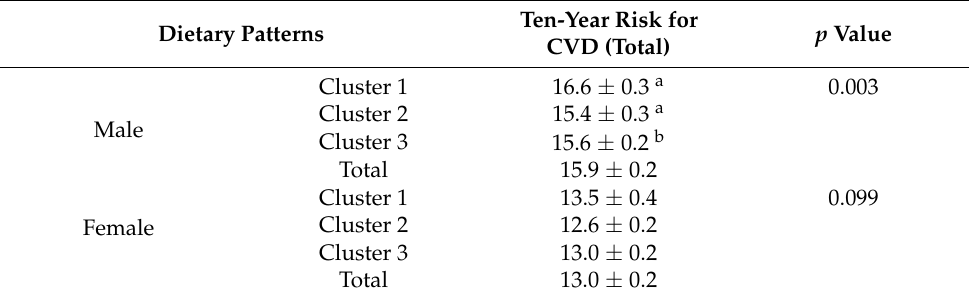
Table 2. Ten-year risk for cardiovascular disease (CVD) according to dietary patterns.